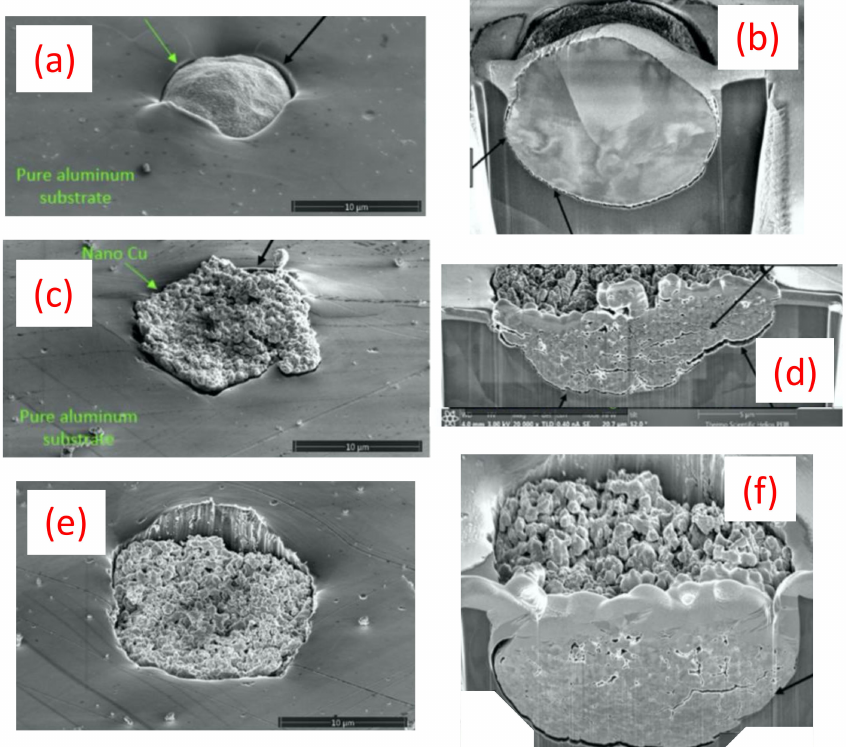
Figure 12. Micrographs of “as-impacted” and cross-sections of the single-particle impacts from advanced LIPIT study of a GA Cu powder particle at 701 m / s shown in ( a ) and ( b ), respectively, and spray-dried Cu powder particles at 770 m / s in ( c ) and ( d ), respectively, and spray-dried Cu powder particles at 884 m / s in ( e ) and ( f ). The black arrows are indictive of interesting bonding and deformation features (such as pore densification and particle / substrate void formation in ( d ) and mechanical interlocking in ( b